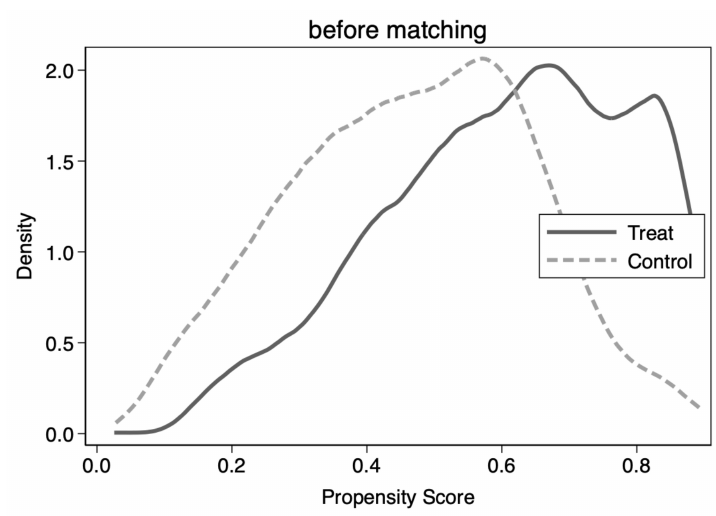
Figure 3. Kernel density of treated and control groups before